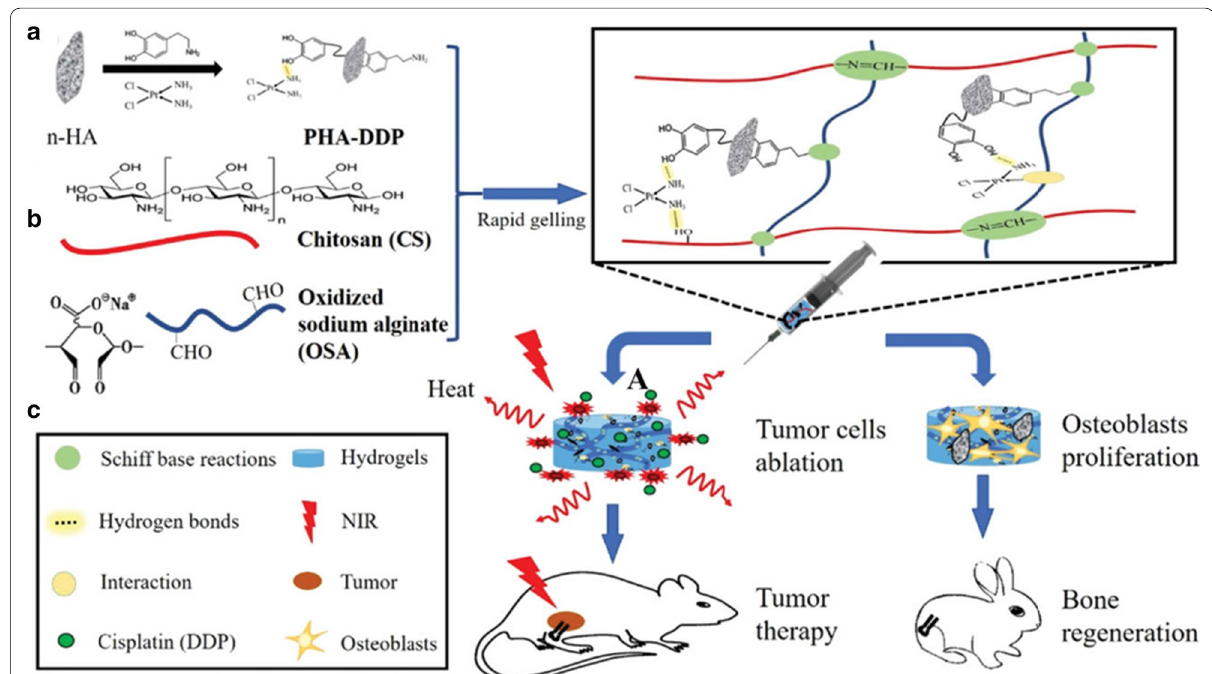
Fig. 3 Schematic illustration of the formation of bifunctional OSA-CS-PHA-DDP hydrogels and bioapplication [40]. Copyright 2019 Macromol.